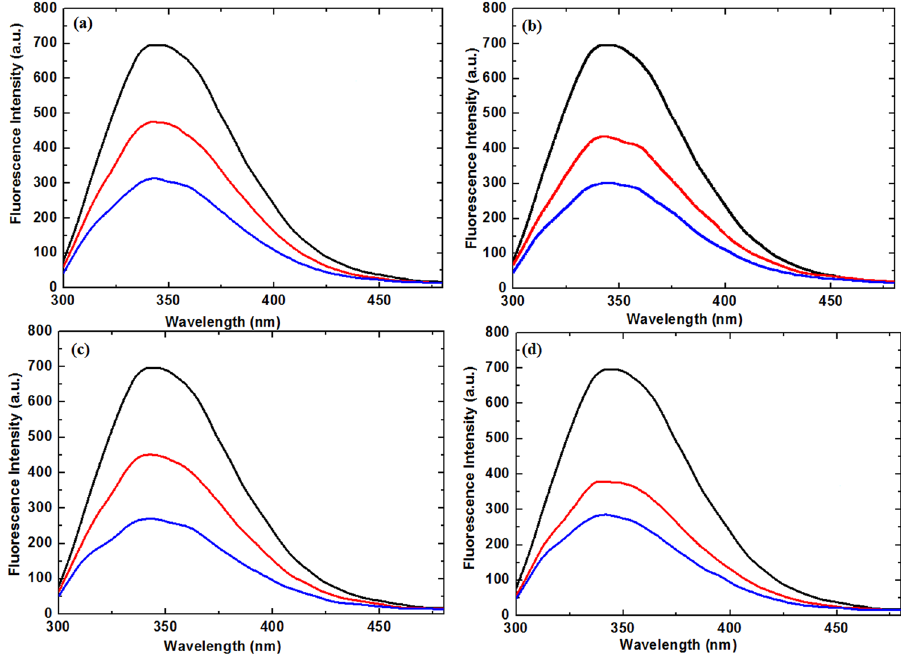
Figure 3. Fluorescence spectrum after plasma treatment. Spectrum were detected after ( a ) Air-DBD; ( b ) N 2 - DBD; ( c ) Air-APPJ and ( d ) N 2 -APPJ treatment for 8 min (red) and 12 min